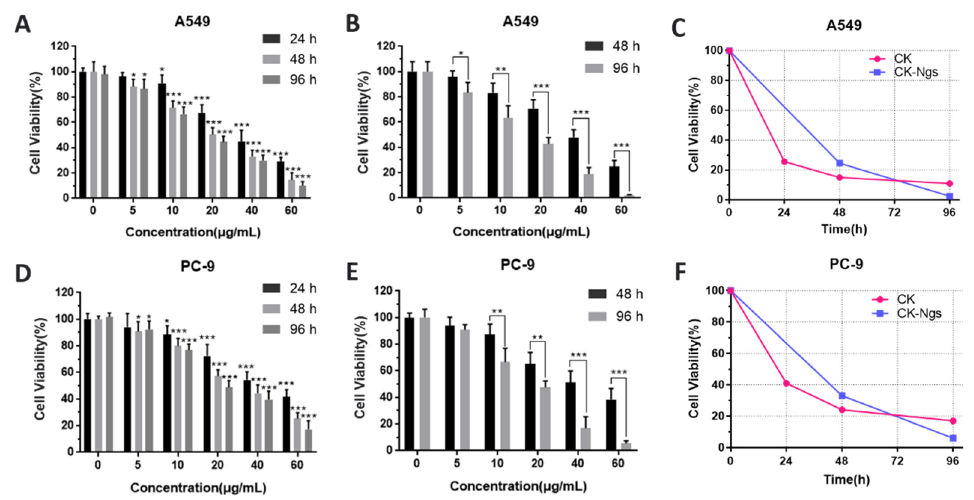
Figure 6. Analysis of the survival rate and line graph of the two drugs on A549 and PC-9 cells. The survival rate of CK in A549 ( A ) and PC-9 cells ( D ). The cytotoxicity of CK-Ngs to A549 ( B ) and PC-9 cells ( E ). The time line chart of the survival rate of CK ( C ) and CK-Ngs ( F ) cells. (* represents p < 0.05, ** represents p < 0.01, *** represents p < 0.001).